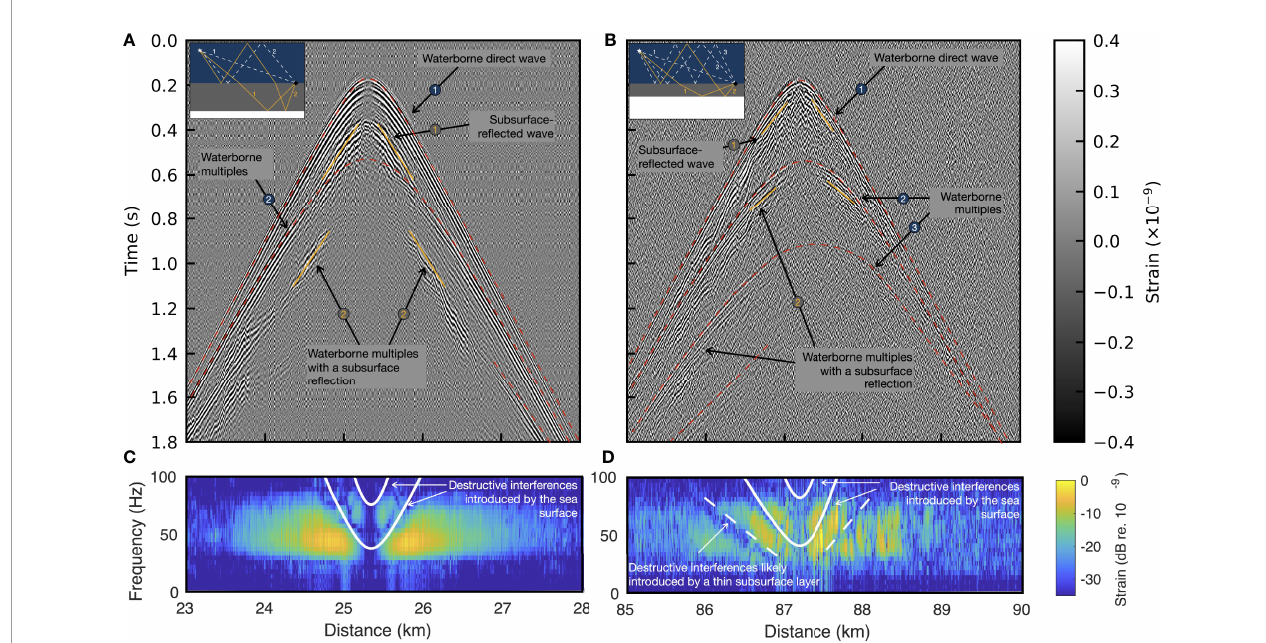
FIGURE 6 | Correlated seismic pro fi les from non-stereotyped whale calls. Analysis of a D-call (A, C) inside [last from Figure 2D (25.1km] and (B, D) outside (at 458 s on Figure 5 ) Isfjorden. (A, B) correlated seismic pro fi les at different locations. Key seismic events are highlighted and described by schematic Earth ’ s models in the insets. Observed and modeled interference patterns generated by (C) the sea surface (D) the sea surface and a thin sub-surface